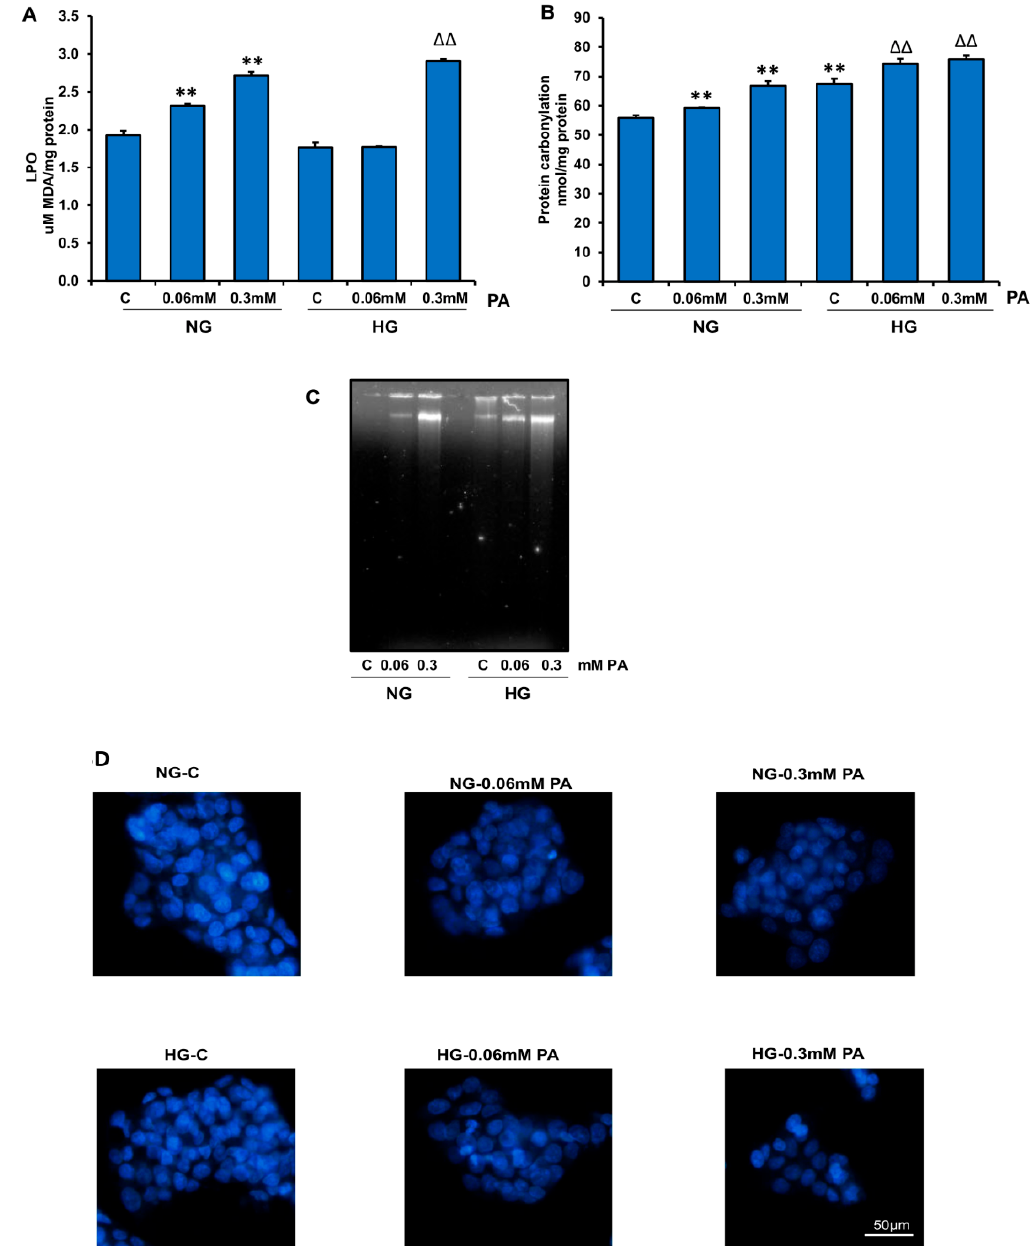
Figure 3. E ff ect of high glucose / high palmitic acid (HG / HPA) on lipids, proteins and DNA degradation. Lipid peroxidation (LPO) was measured as the total amount of malonedialdehyde ( A ), as per the vendor’s protocol (Oxis Research, Inc.). Protein carbonylation ( B ) was assayed by the dinitrophenylhydrazine (DNPH) method, as described in the Materials and Methods section. DNA fragmentation ( C ) was analyzed by agarose gel (2%) electrophoresis and ethidium bromide staining. DNA fragmentation was also analyzed microscopically ( D ) by staining the treated cells with Hoechst 33,342 dye, as described in the Materials and Methods section. Asterisks indicate significant di ff erences (** p ≤ 0.005) relative to untreated control cells under normal glucose condition (NG-C), and triangles indicate significant di ff erences ( ∆∆ p ≤ 0.005) relative to untreated control cells under high glucose condition